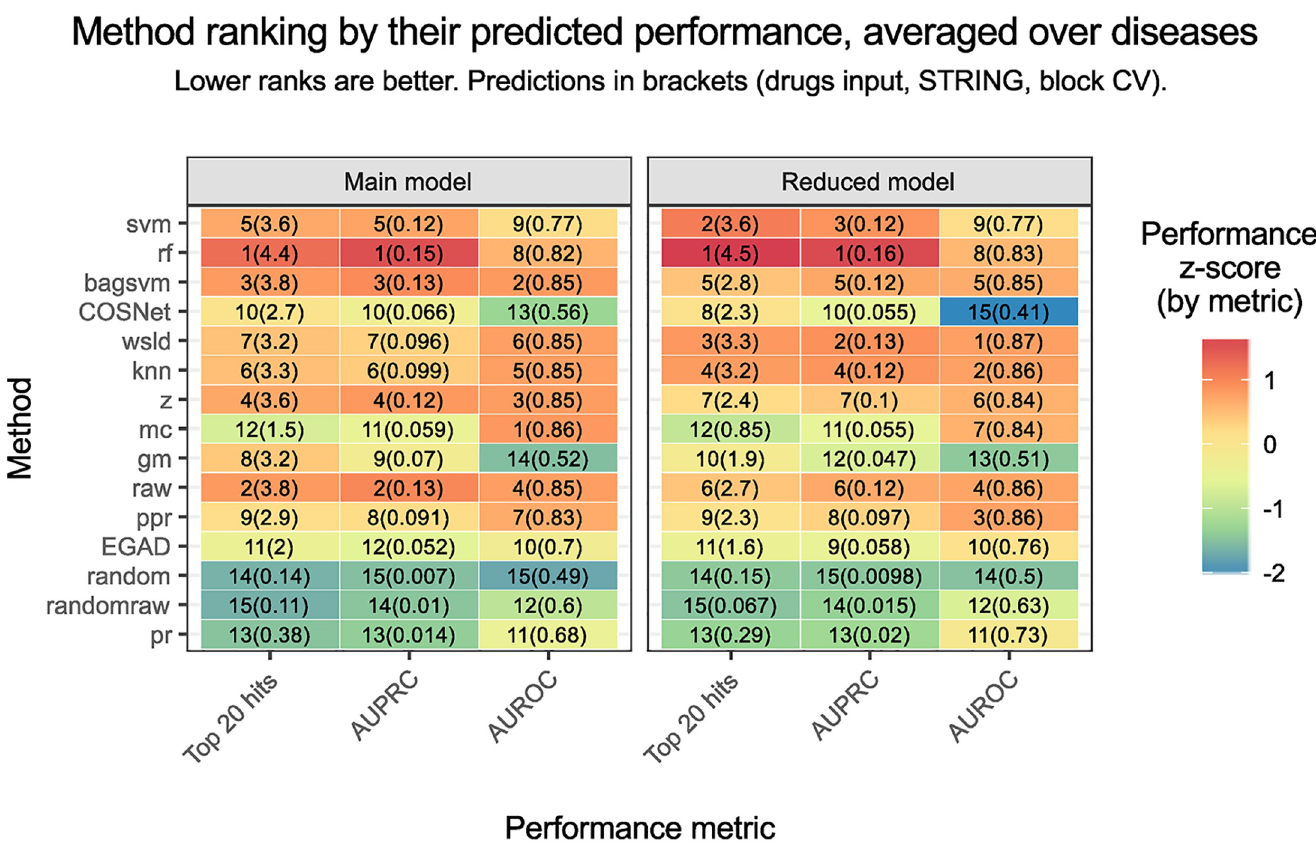
Fig 5. Ranking of all the methods. Ranking according to the predictions of the main explanatory models (left) and the reduced explanatory models within the STRING network and block cross-validation (right), in both cases on the drugs input and averaging over diseases. The main models serve as a global description of the metrics, whereas the reduced models are specific to the scenario of most interest. A column-wise z-score on the predicted mean is depicted, in order to illustrate the magnitude of the difference. Note how the top 20 hits and the AUPRC metrics lead to similar conclusions, as opposed to